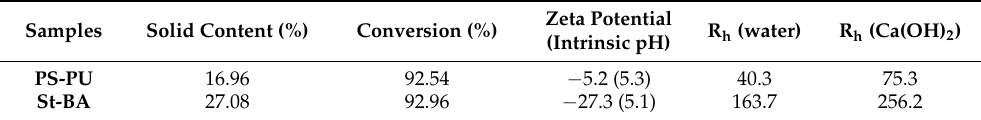
Table 3. Physiochemical parameters of the